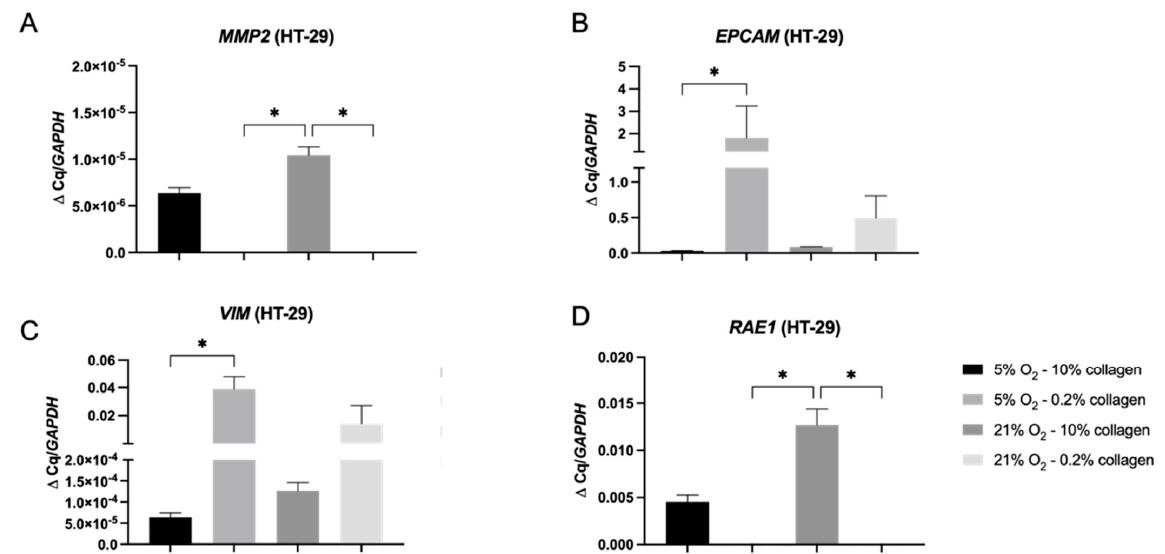
Figure 6. Gene expression within HT-29 tumouroids grown in differing collagen and oxygen con- centrations. ( A ) MMP2 , ( B ) EPCAM , ( C ) VIM , and ( D ) RAE1 mRNA levels expressed by day 21 in HT-29 tumouroids within stiff (10% collagen) or soft (0.2% collagen) and cultured under physiological hypoxia (5% O 2 ) or normoxia (21% O 2 ). The fold change shown is normalized relative to refer- ence gene GAPDH . Significance shown for Kruskal–Wallis multiple comparisons test with Dunn’s post hoc correction. All p -value significance is indicated as: * p < 0.05.